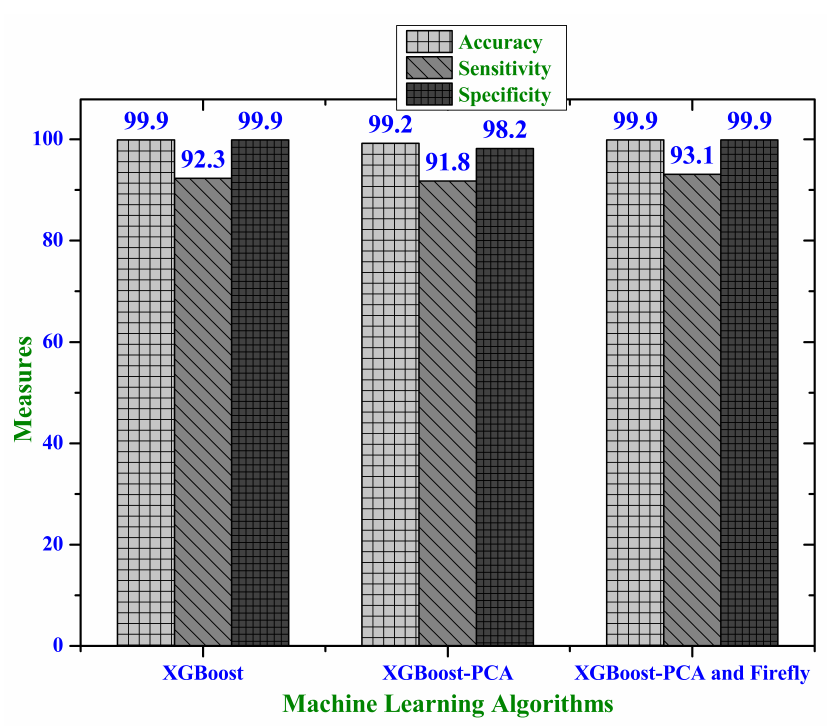
Figure 8. Performance evaluation of XGBoost classifier.